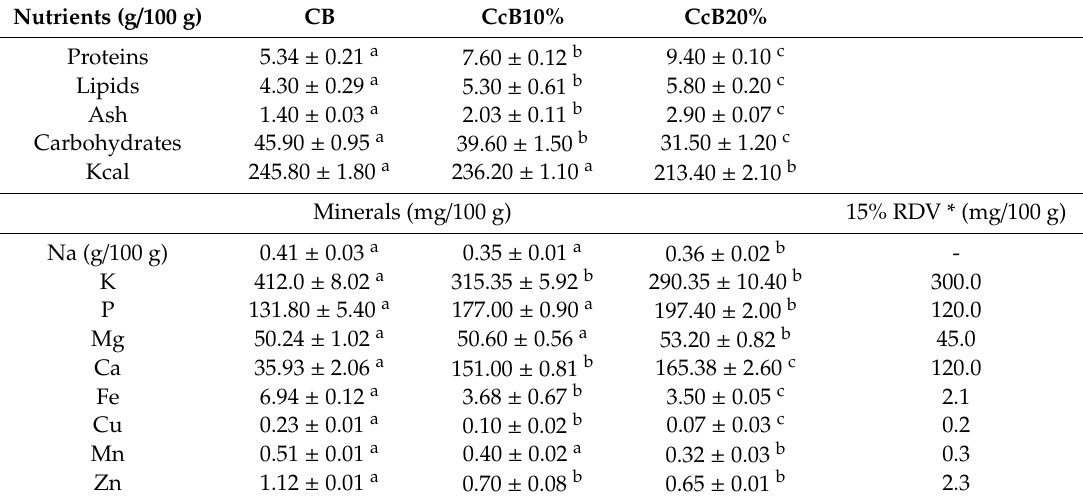
Table 6. Nutritional value (g / 100 g), including mineral profile (mg / 100 g), for control bread (CB) and Cc breads (CcB5% up to